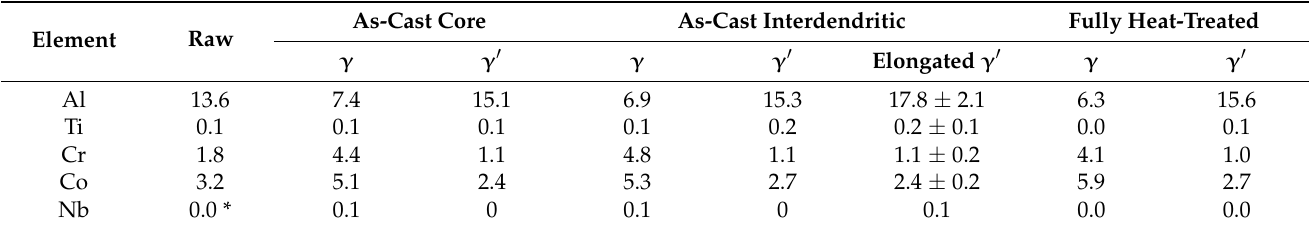
Table 1. Compositions (at. pct.) of raw material, γ and γ (cid:48) phases measured in as-cast or fully heat-treated blades [19,20] by